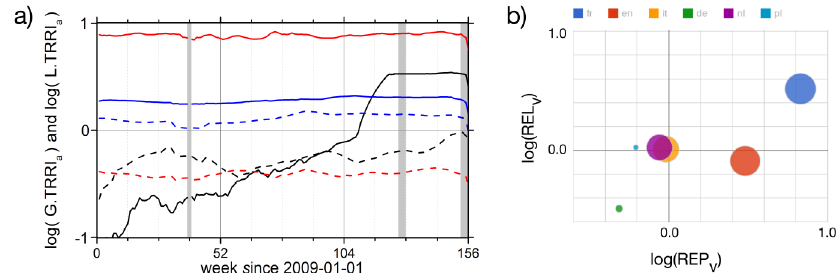
Fig 6. (a) Contextual local and global time resolved relevance indexes L.TRRI a ( t ) (straight lines, Eq (5)) and G.TRRI a ( t ) (dashed lines, Eq (6)) for Wikipedia pages regarding the companies Oracle (red), Capgemini (blue) and for Apache Hadoop (black) between 2009-01-01 and 2011-12-31 at weekly resolution. In (b), the text volume representation and relevance indexes are shown (as in Fig 2b) for Capgemini regarding six different languages: the the highest representation is in French. In this case, the local context can be defined as a hybrid context by two CNs — French because of the country of origin, and English because of international IT business. If only one language is used, as in (a), one cannot clearly differentiate between local and global